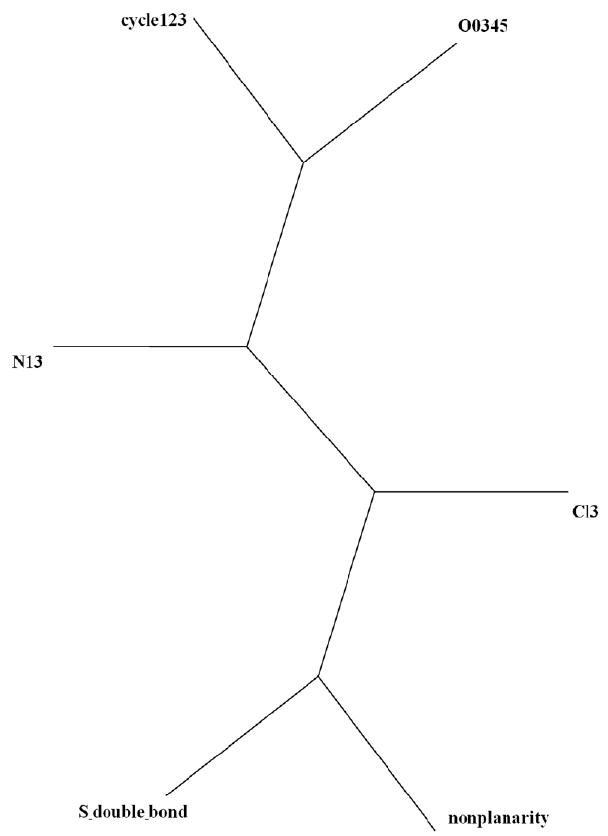
Figure 8. Radial tree for the vector properties corresponding to the